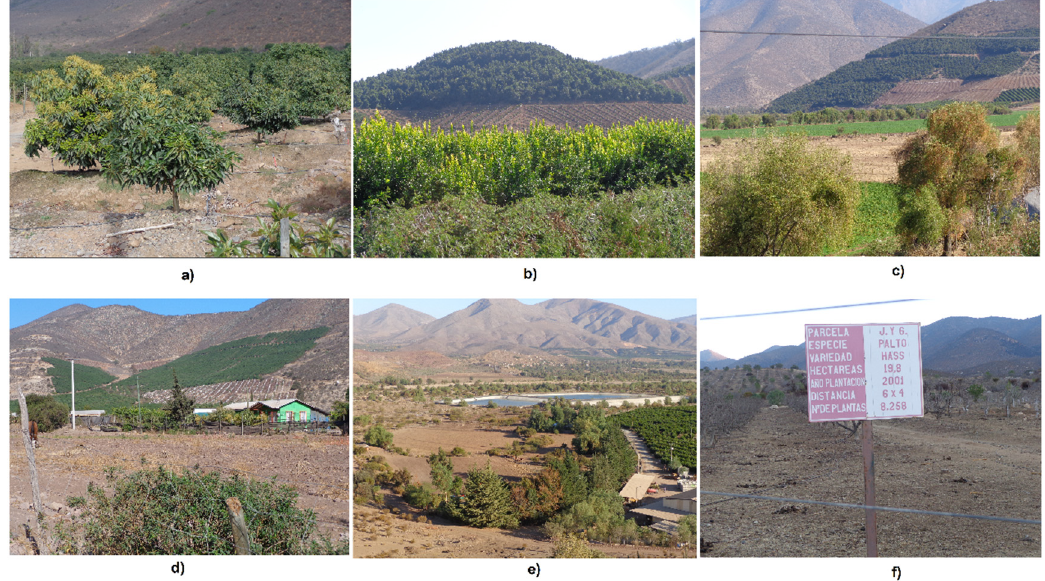
Figure 15. Photographs taken by the authors of the study area; ( a – c ) avocado land in Ligua watershed, and ( d ) avocado land, ( e ) reservoirs, and ( f ) abandoned avocado land in Petorca watershed.